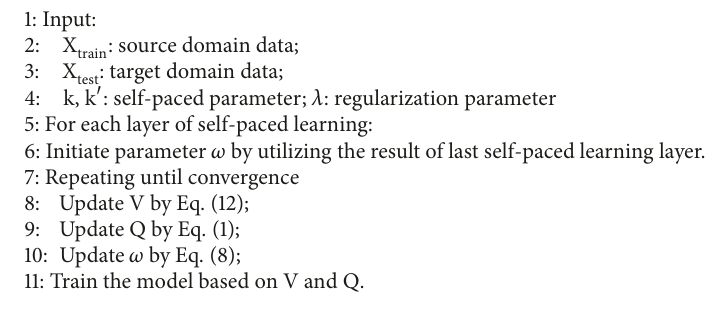
Algorithm 1: The algorithm of robust self-paced learning